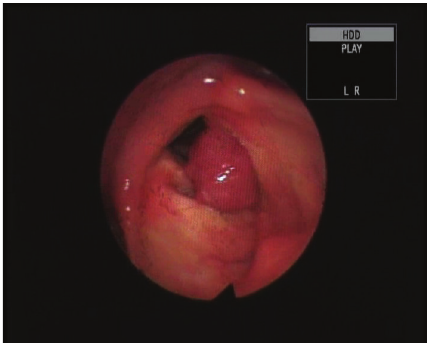
Figure 1: Laryngeal fiberscopy revealed a reddish pedunculated voluminous mass localized in the left false cord and ventricle.